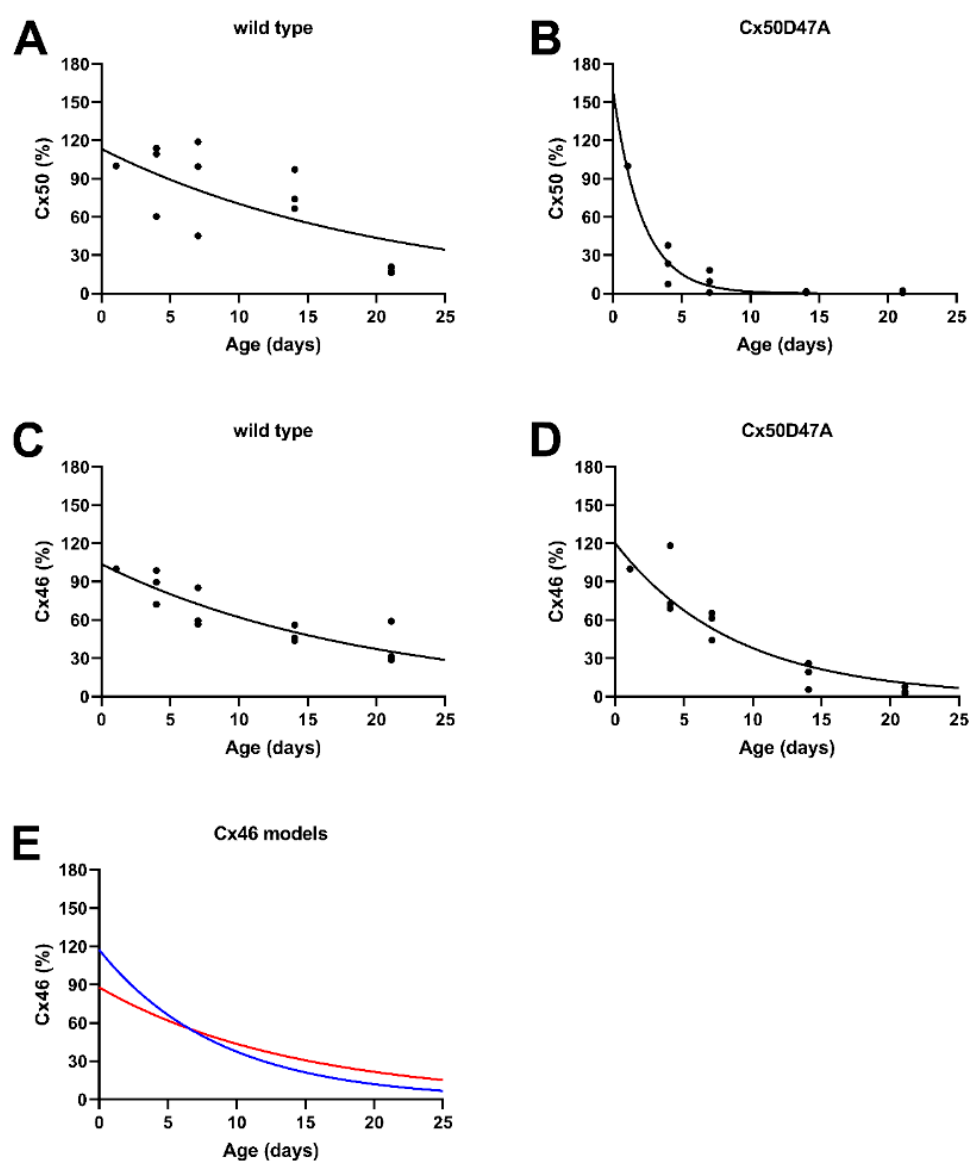
Figure 4. The data regarding the age-dependent decreases in total levels of Cx46 and Cx50 in the lenses of wild-type and homozygous Cx50D47A mice could be fit to single exponential curves. ( A – D ) The data from the three independent sets of immunoblots of connexin levels shown in Figure 3C,D were fit to single exponential decay curves of the form y = C*e − k*t . ( A ) For Cx50 levels in wild-type (C3H background) mice, the data were best fit by y = 113*e − 0.0477*t (r 2 = 0.7333). ( B ) For Cx50 levels in Cx50D47A mice, the data were best fit by y = 159.095*e − 0.4665*t (r 2 = 0.9944). ( C ) For Cx46 levels in wild-type mice (C3H background), the data were best fit by y = 103.7676*e − 0.0513*t (r 2 = 0.9516). ( D ) For Cx46 levels in Cx50D47A mice, the data were best fit by y = 120.179*e − 0.1151*t (r 2 = 0.99418). ( E ) The impact of co-oligomerization between wild-type Cx46 and Cx50D47A upon Cx46 decay in the Cx50D47A mice was modeled by adding different proportions of the values from the curves shown in panels C and B. This approach did not yield a very satisfactory match. The example shown as a red line represents a curve generated using 60% wild-type Cx46 ( C ) and 40% mutant Cx50 ( B ). The curve fit to the actual Cx46 data (from panel D ) is shown as a blue line (which could also be generated by progressively reducing the relative proportion of wild-type Cx46 from 86% at day 1 to 30% at day